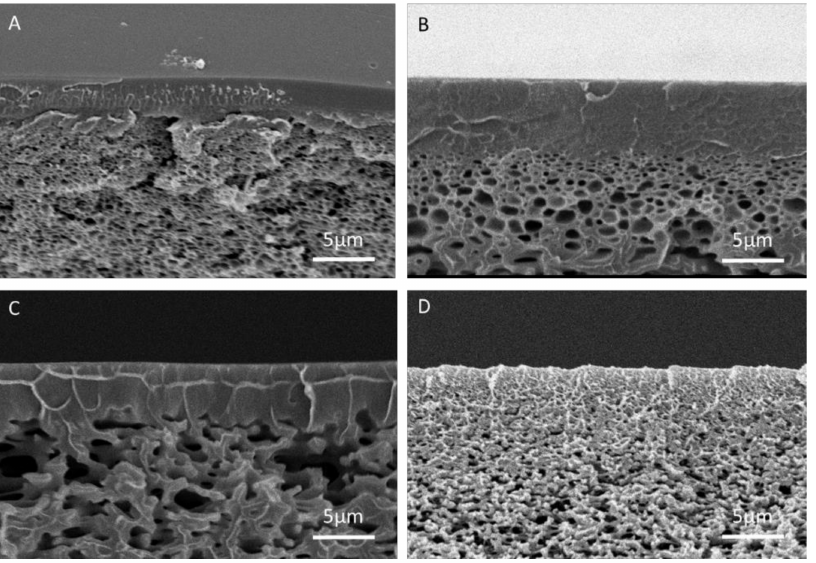
Figure 8. Cross section of membranes with solvent/co-solvent (DMF/IPA) ratios in the solvent mixture of ( A ) 100/0, ( B ) 90/10, ( C ) 80/20, ( D ) 70/30.